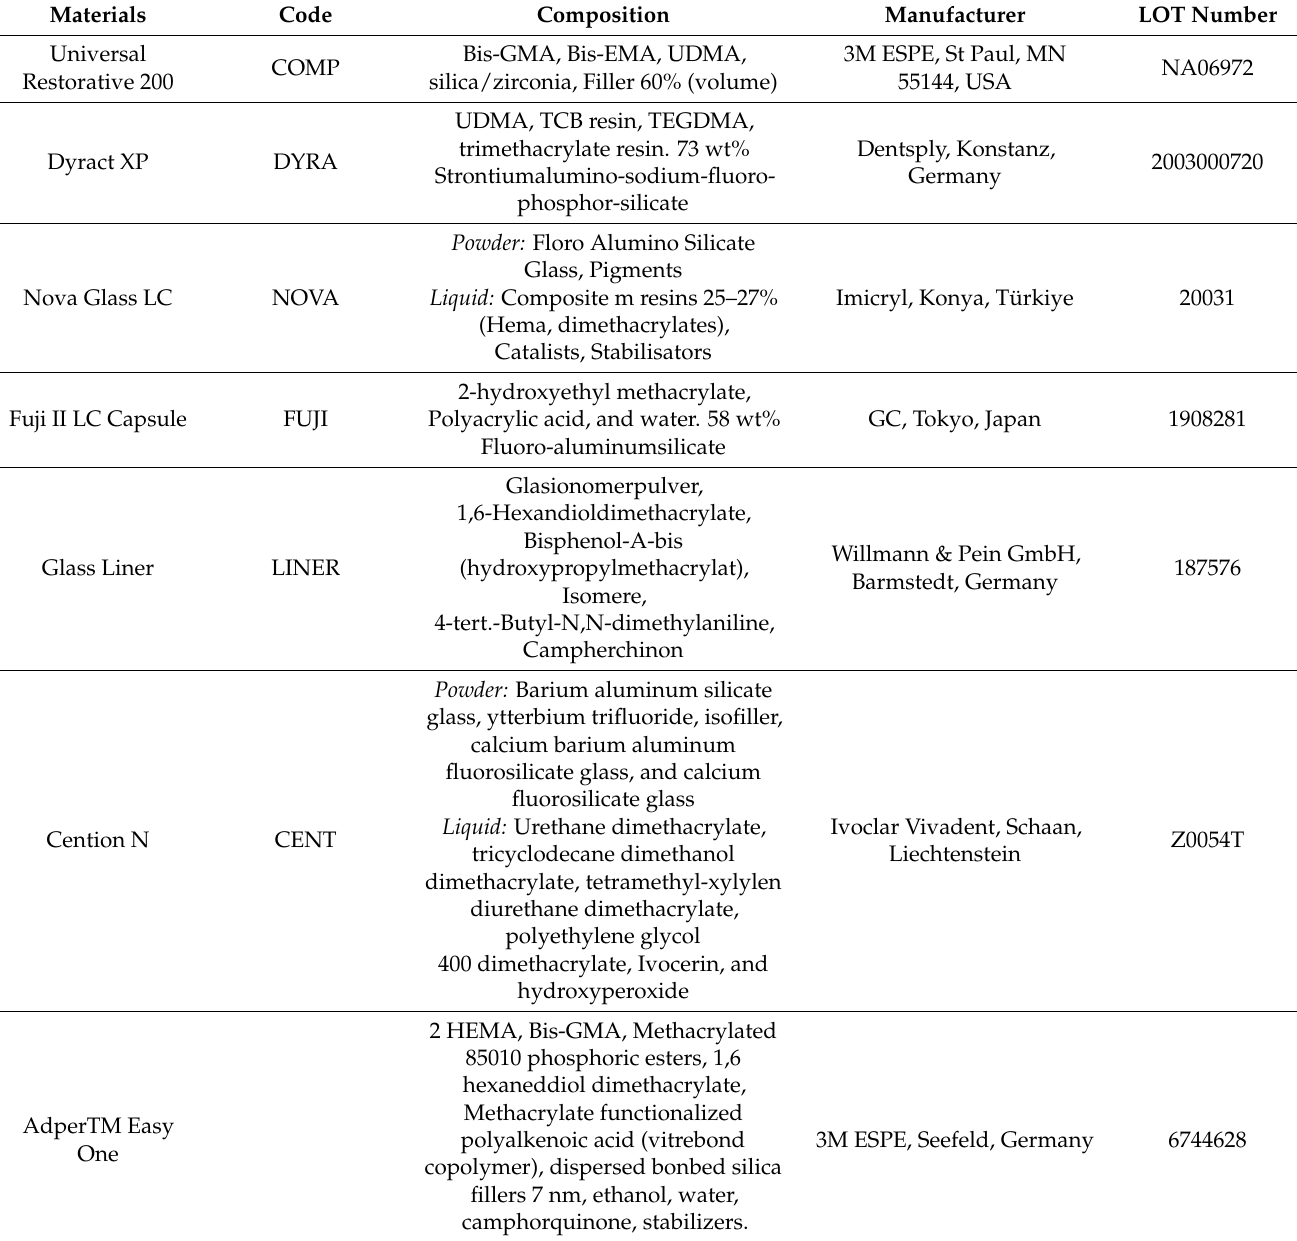
Table 1. The technical profiles, codes, and compositions of the dental restorative